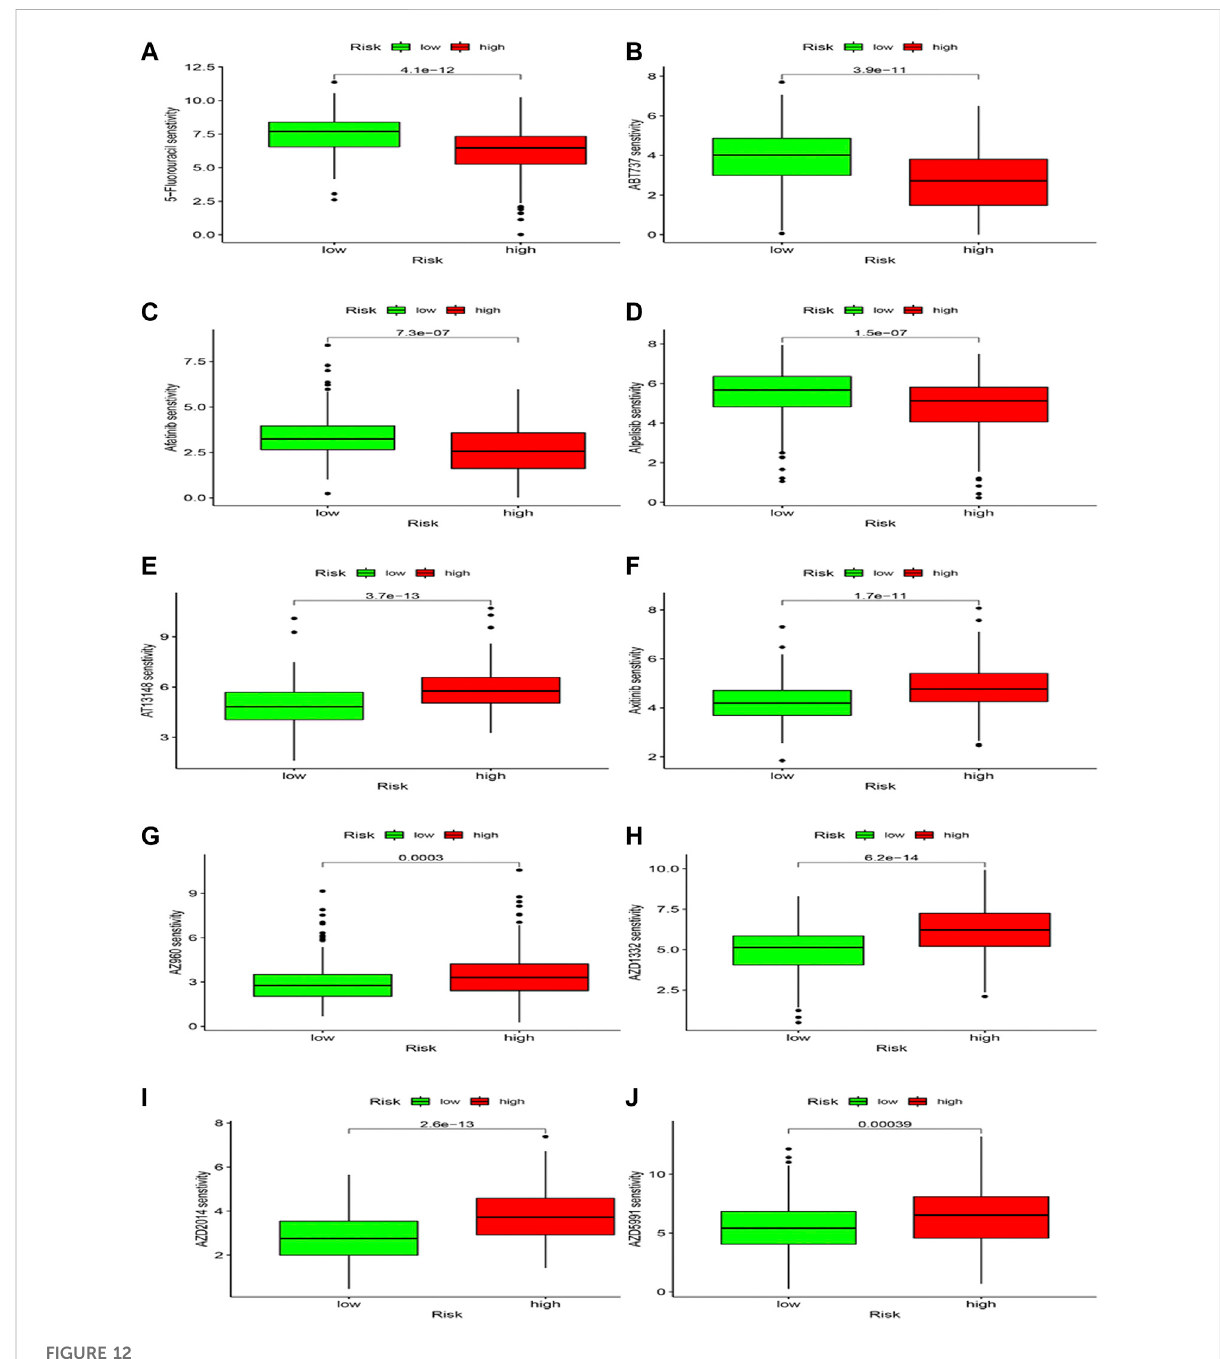
FIGURE 12 Drug sensitivity